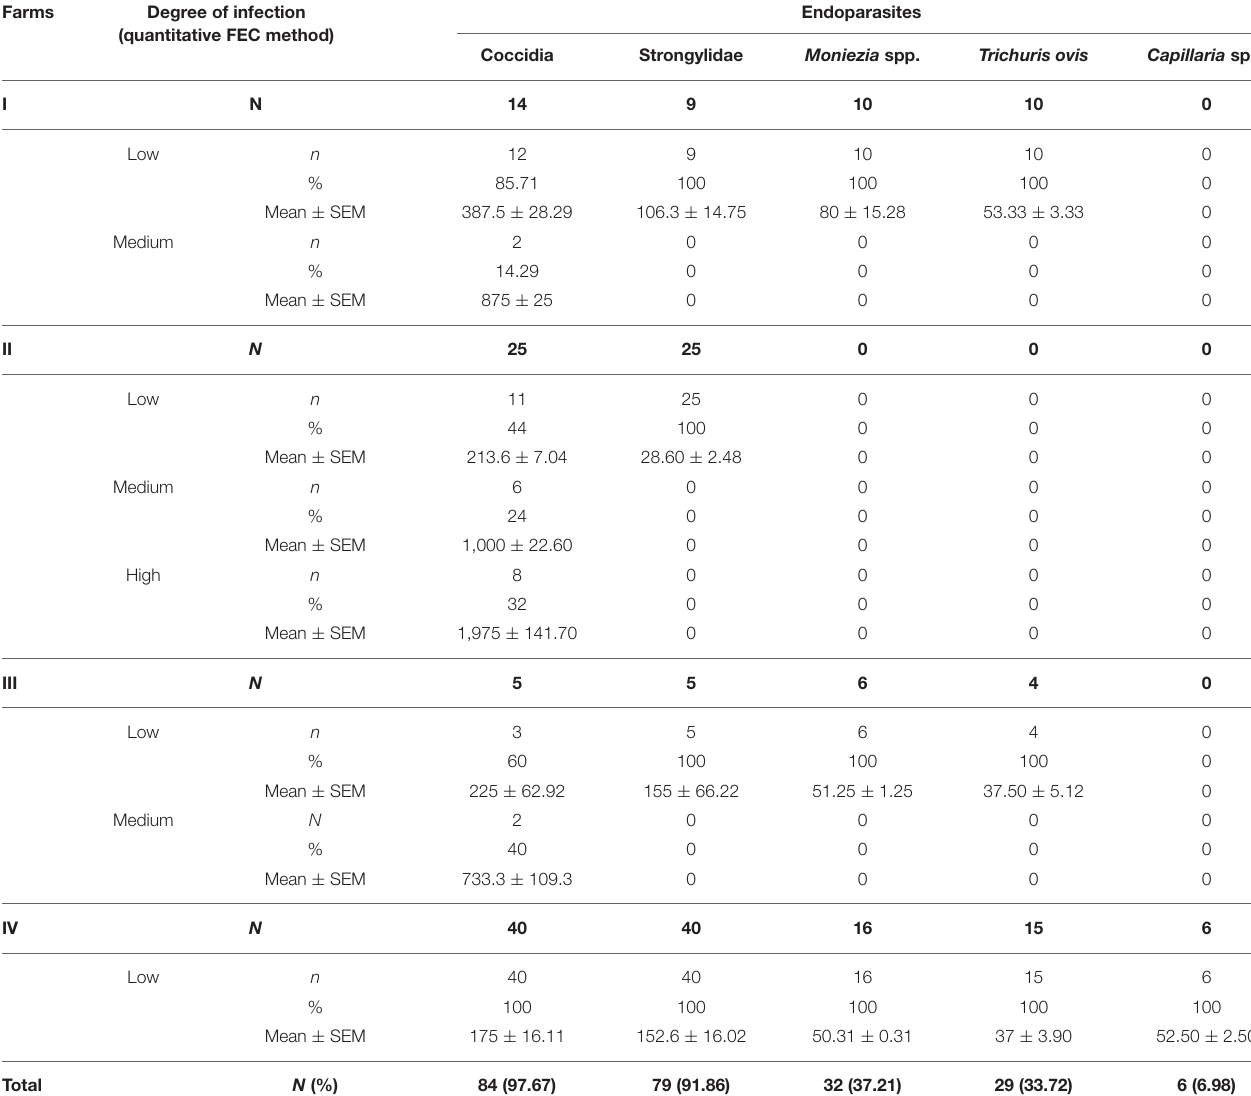
TABLE 6 | Quantitative assessment of fecal samples in in goats examined on four farms in Serbia. Farms Degree of infection Endoparasites (quantitative FEC method) Coccidia Strongylidae Moniezia spp. Trichuris ovis Capillaria